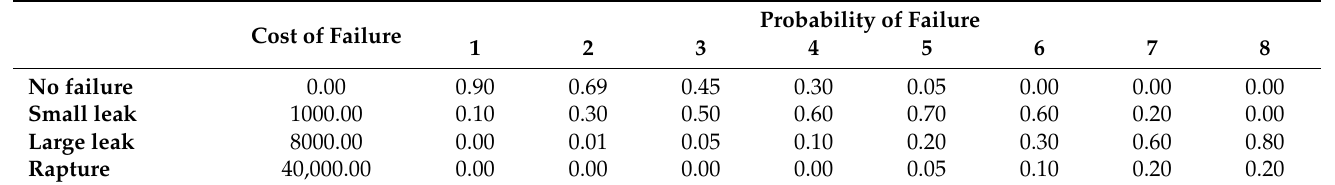
Table 5 presents the reward values applied to the test model. Table 4. Cost of failure (modified from the source: Heidarydashtarjandi, Prasad-Rao, and Groth [6].)